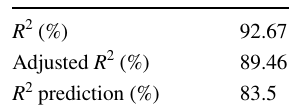
Table 12 High, medium, and low levels of variables required to